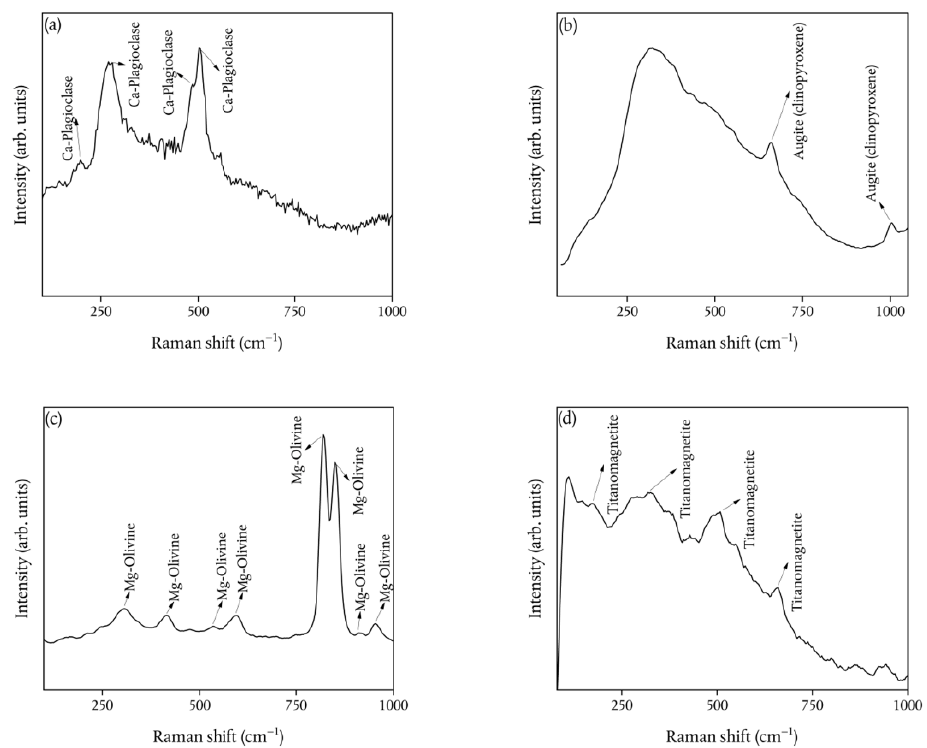
Figure 9. Ca-plagioclase ( a ); Augite (clinopyroxene) ( b ); Mg-olivine ( c ); Titanomagnetite ( d ) Raman spectra, each one being the average of 30 measurements exhibiting similar profiles, collected on different grains of each investigated sample.